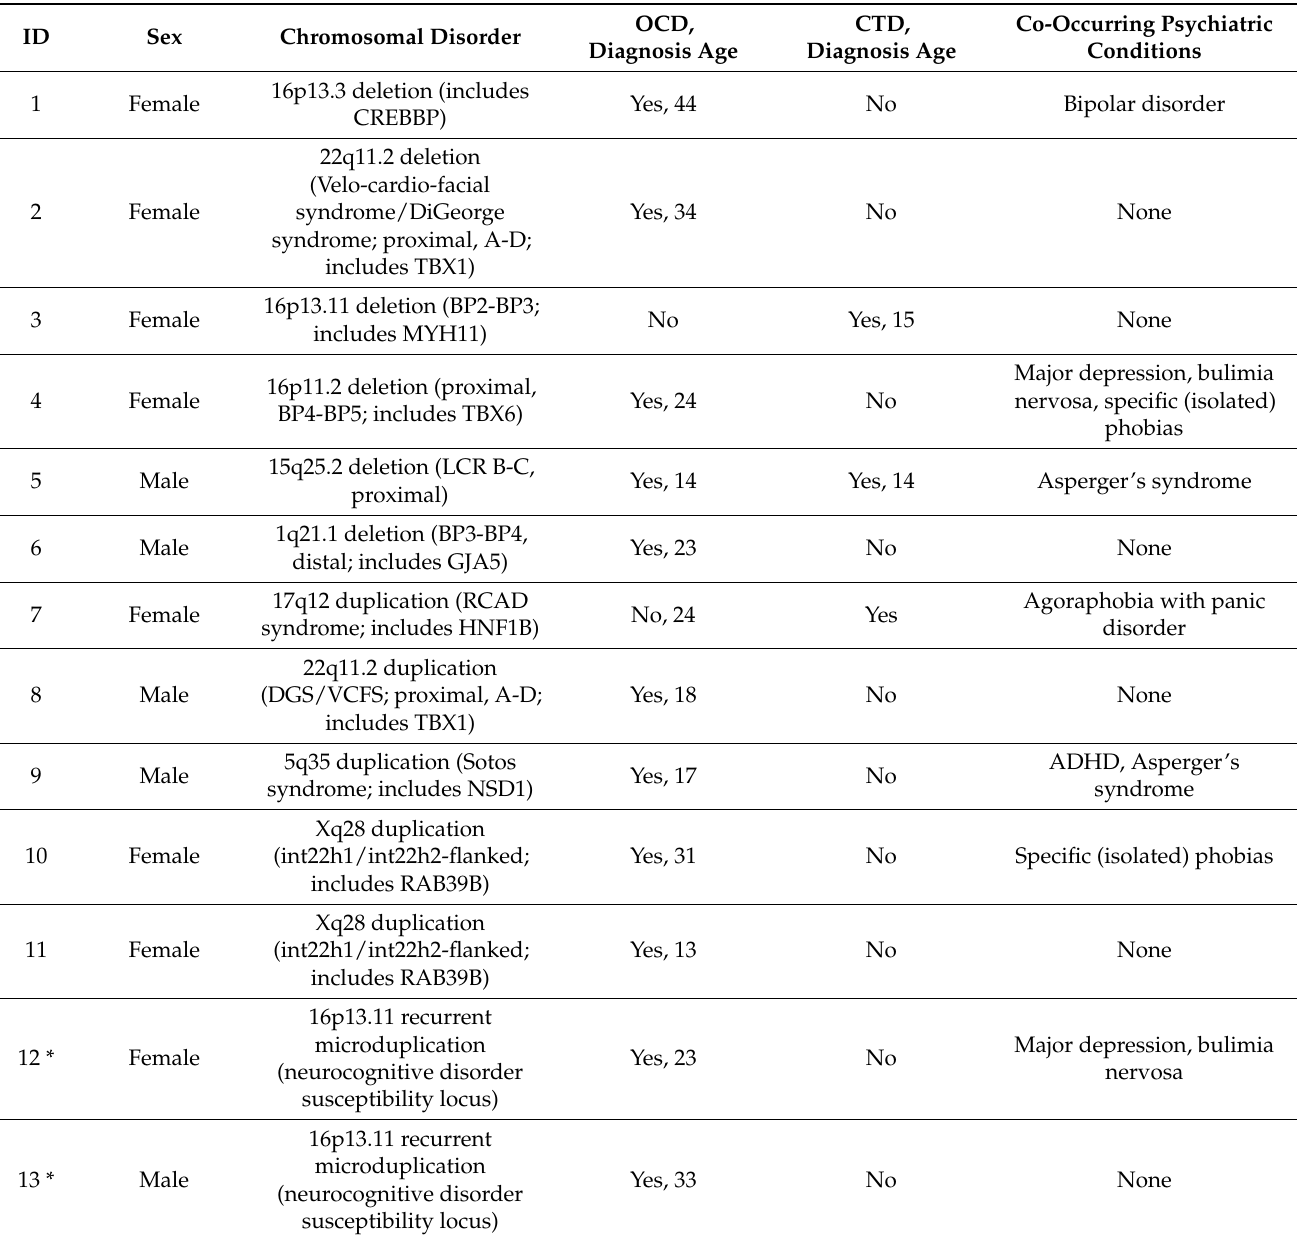
Table 3. Known genomic disorders